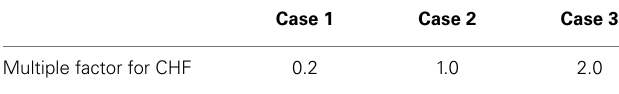
Table 8 | Sensitivity analysis on HTC for CHF .